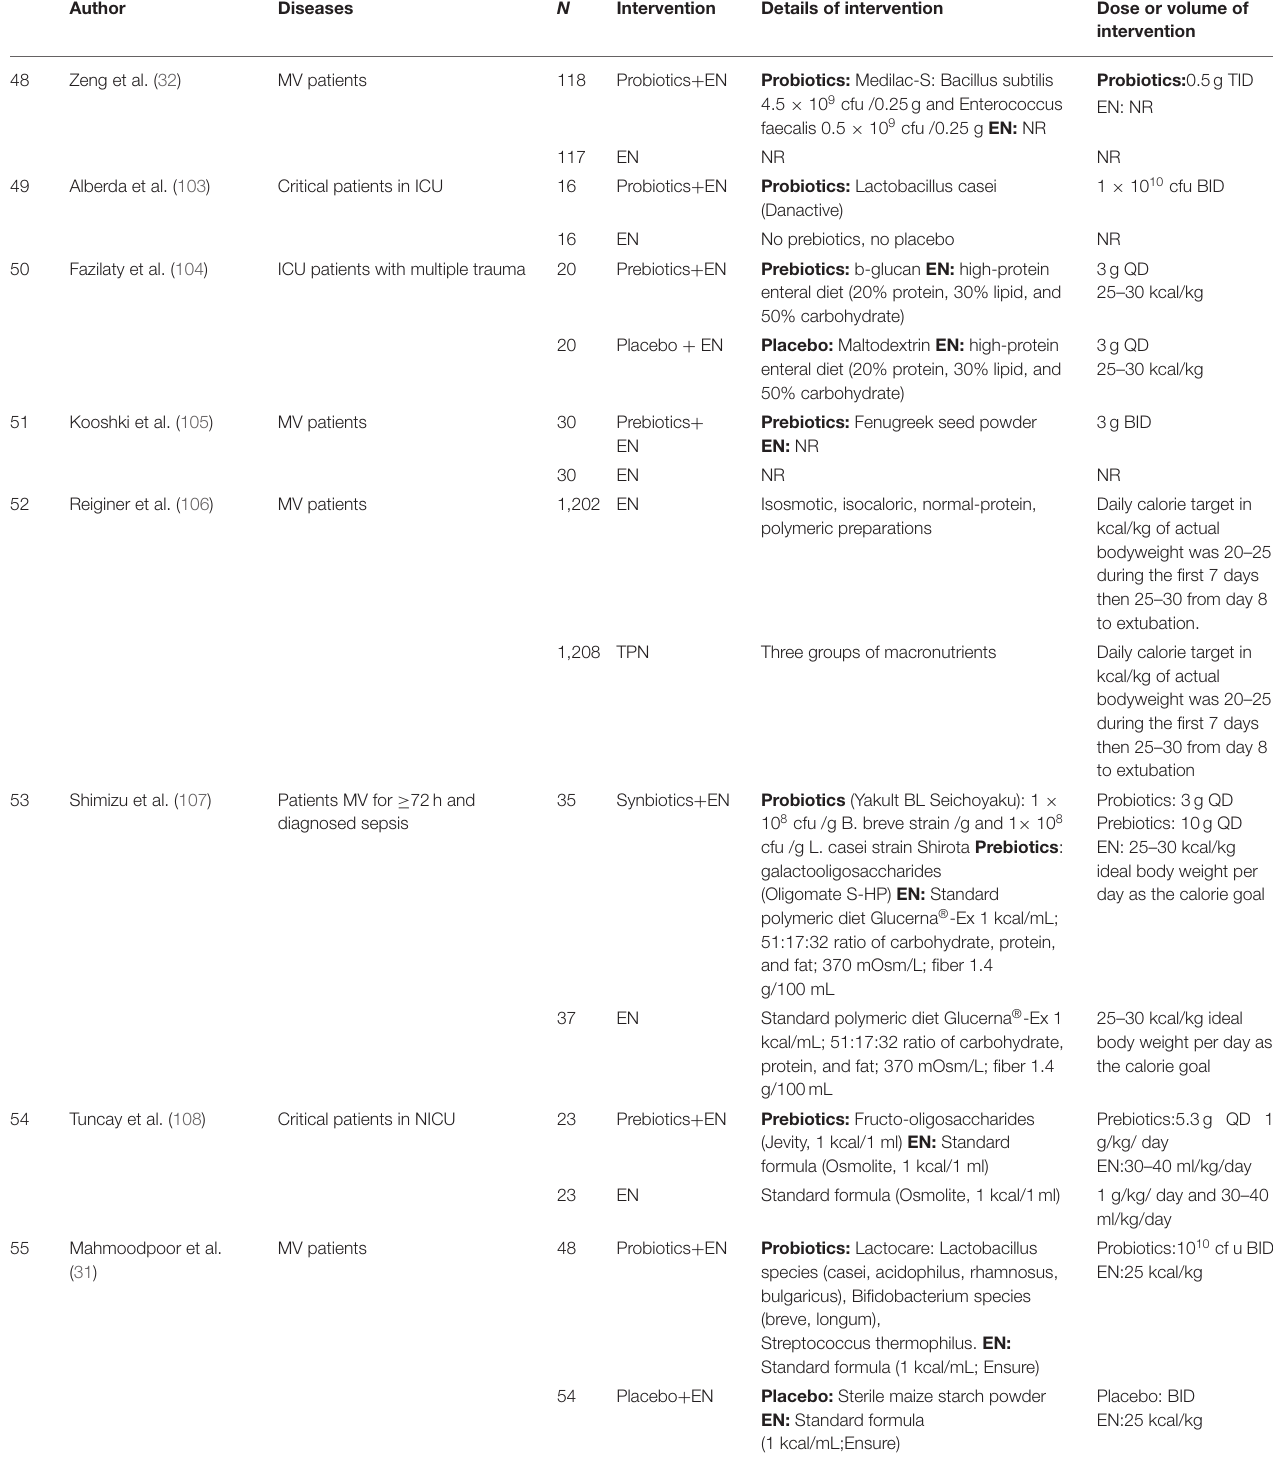
Placebo: Sterile maize starch powder EN: Standard formula (1 kcal/mL;Ensure)